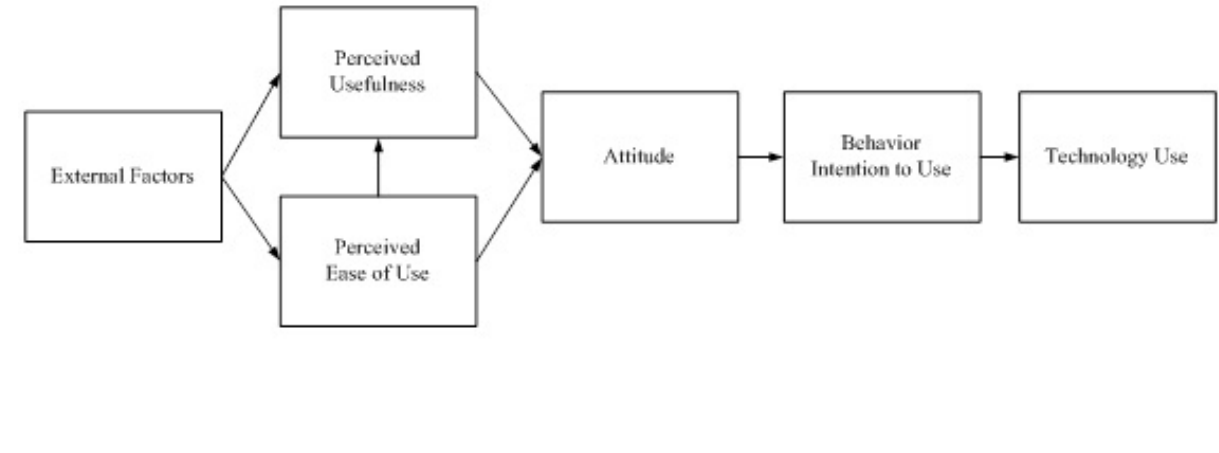
Figure 1. The Technology Acceptance Model predicts that ease of use and usefulness will influence an individual’s attitudes towards, intention to use, and acceptance of the